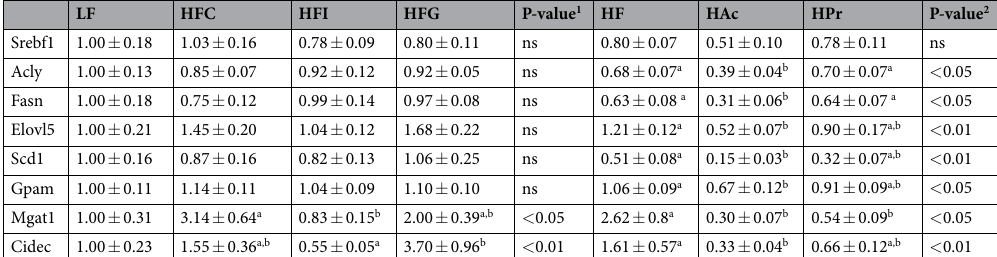
Table 2. Inulin and acetate alter hepatic gene expression of enzymes involved in lipogenesis. Table shows the summary of relative mRNA expressions of lipid metabolism-related enzymes after 30 weeks of feeding C57BL/6JRj mice with a semi-synthetic low-fat diet (LF) or high-fat diets (HF) supplemented with either 10% dietary fibre (HFC: 10% cellulose; HFI: 3% cellulose + 7% inulin; HFG: 3% cellulose + 7% guar gum) or 5% SCFA with different Ac:Pr ratios, a high acetate (HAc; 10:1 Ac:Pr) or high propionate diet (HPr; 1:2.5 Ac:Pr). Data are mean + / − SEM, n = 8–9, normalized to LF-diet to a value of 1. Statistical tests were performed among 1 dietary fibre groups (HFC, HFI, HFG) and 2 SCFA-groups (HF, HAc,